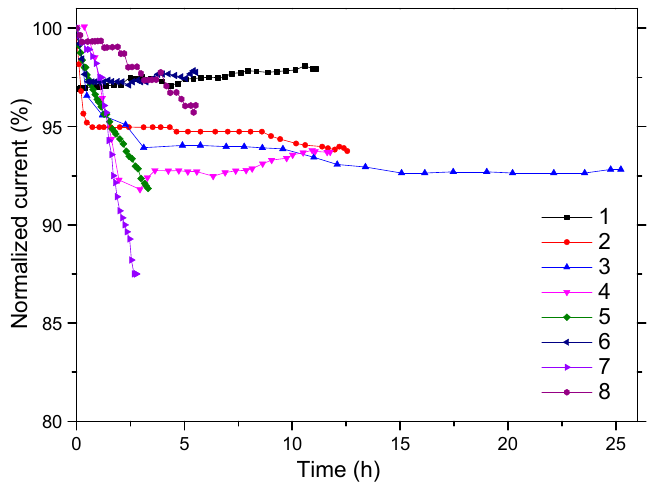
Figure 1. Comparison of stability of 3D ‐ structured non ‐ precious carbon based electrocatalysts: (1) NHCs (N ‐ doped hierarchically carbon) (at 0.5 V vs RHE) [27]; (2) 3D ‐ HPC ‐ N (N ‐ doped ‐ 3D ‐ hierarchically porous carbon materials) ‐ 850 (at 0.55 V vs RHE) [28]; (3) 3D Co ‐ N ‐ OMMC ‐ 0.6 (Co(NO 3 ) 2 ∙ 6H 2 O) (ordered macro ‐ mesoporous carbon) (at 0.6 V vs RHE) [29]; (4) 3D hierarchical porous ‐ CoFe 2 O 4 hollow nanospheres (at 0.56 V vs RHE) [34]; (5) Mn x Co 3 x O 4 ( x = 0.4) [36]; (6) Nanosheet Co 3 O 4 ‐ doped ‐ graphene ‐ 3D [38]; (7) 2D ‐ CoAl ‐ LDH@ZIF ‐ 67 ‐ 800 (LDH: layered double hydroxides, ZIF: zeolitic imidazolate framework [39]; and (8) 3D ‐ N ‐ doped ‐ TTF (thermalized triazine ‐ based framework) ‐ 700 (at 0.6 V vs RHE) [41].